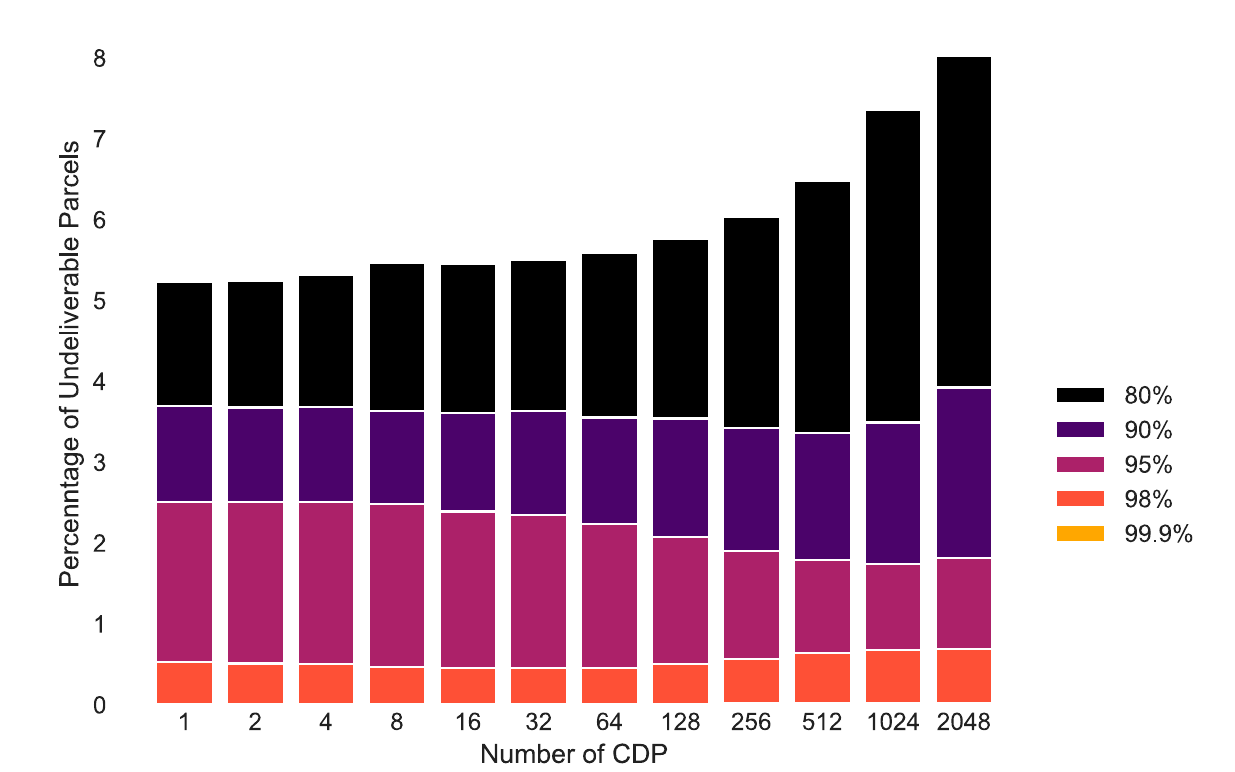
Figure 8. Percentage of parcels that could not be delivered per year due to a lack of locker availability if the number of parcel lockers is equal to the 80-percentile, 90-percentile, etc. (Density 1.0).